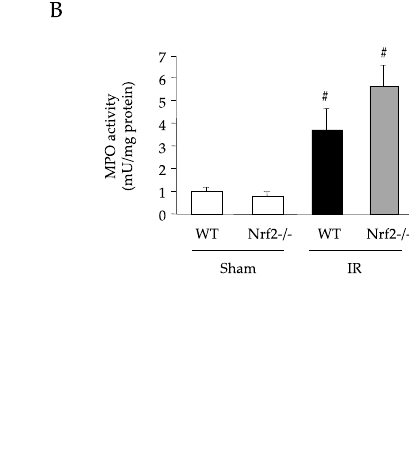
Figure 4. Effect of nuclear factor-erythroid 2-related factor 2 (Nrf2) deficiency on the inflammatory response in intestinal IR injury. ( A ) Luminal protein level (a Bio-Rad Protein Assay kit) (n = 7), ( B ) MPO activity (n = 7), ( C ) tissue TNF- α protein level, and ( D ) tissue KC protein levels (eBioscience ELISA kit) (n = 7). Sham operation or intestinal IR injury was induced in the wild-type and Nrf2- deficient mice. Each value represents the mean ± SEM. # p < 0.05 compared with sham-operated WT mice; * p < 0.05 compared with IR-induced WT mice. Figure 5. Effects of Nrf2 deficiency on HO-1 expression levels and adhesion molecules in intestinal IR injury. ( A ) ho-1 mRNA expression levels (real-time PCR) (n = 7), ( B ) HO-1 protein expression levels (western blotting) (n = 4), ( C ) icam-1 , and ( D ) e-selectin mRNA expression levels (real-time PCR) (n = 7). Sham operation or intestinal IR injury was induced in the wild-type and Nrf2-deficient mice. Each value represents the mean ± SEM. # p < 0.05 compared with sham-operated WT mice; * p < 0.05 compared with IR-induced WT mice. 0(cid:9)5(cid:9) 10(cid:9)15(cid:9)